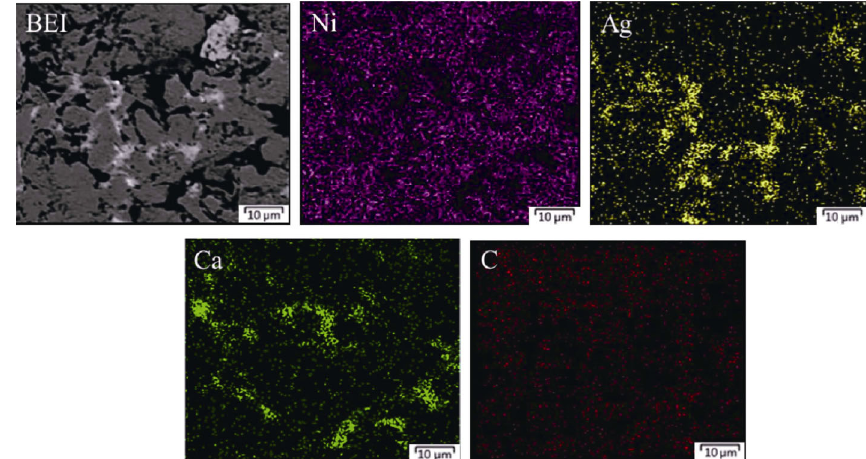
Fig. 3 Back-scattering electron image (BEI) and EDS maps showing the microstructure of composite